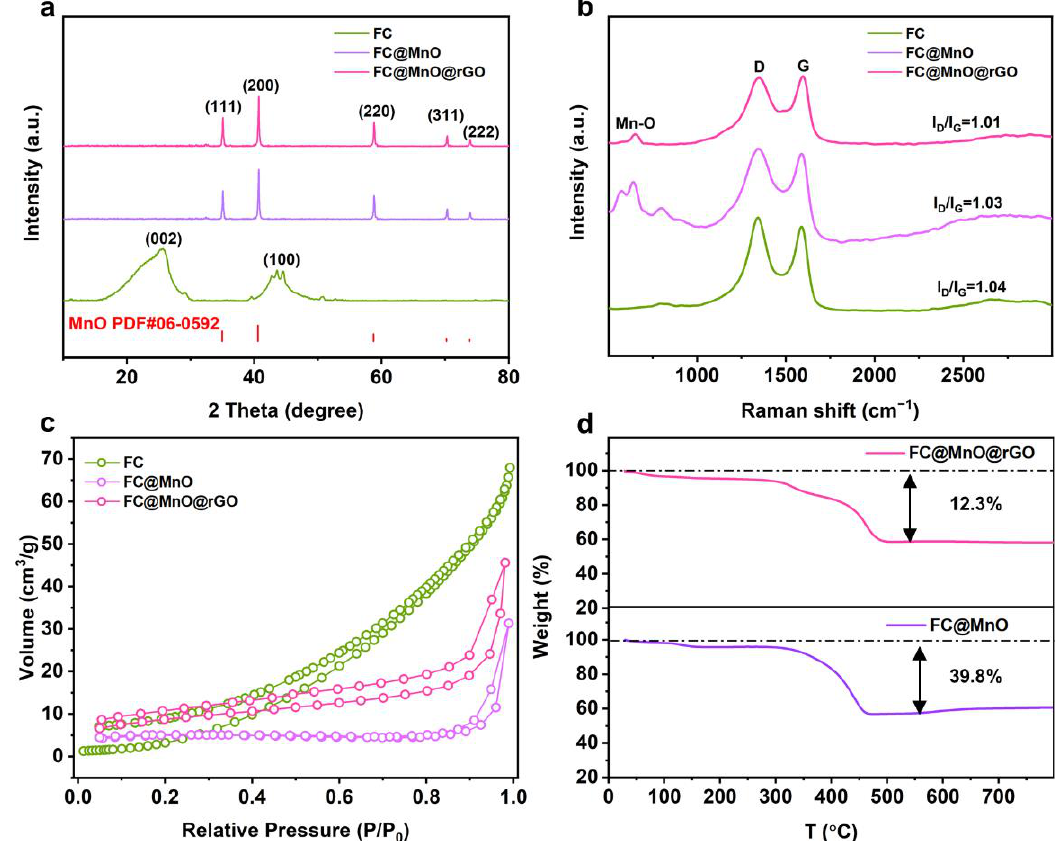
Figure 1. ( a ) XRD curves, ( b ) Raman patterns and ( c ) N 2 adsorption isotherms of FC, FC@MnO and